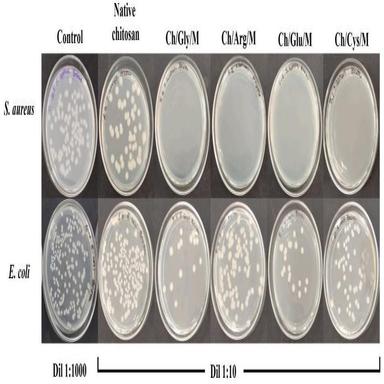
Petri dishes of the antimicrobial assays for native chitosan and permethylated chitosan grafted materials.